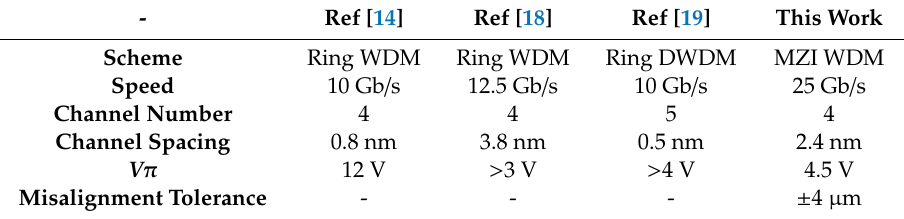
Table 1. The characteristic parameters of this work and the